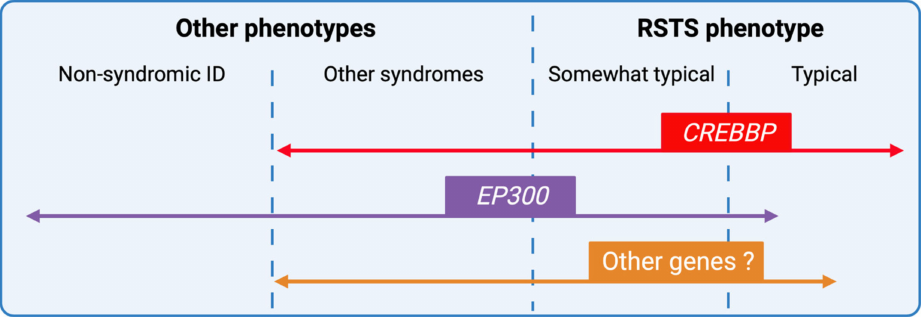
Figure 6. RSTS phenotypic overlap. Next-generation sequencing techniques have increased the number of genomic alterations identified and associated with RSTS phenotype and the phenotypic spectrum leading to complex pheno- type/genotype correlations. CREBBP -mutated individuals present for the majority, a typical clinical diagnosis of RSTS, but the identification of missense mutations in exons 30 and 31 of the gene in patients with non-RSTS phenotype led to the definition of a new clinical entity: the Menke-Hennekam syndrome. EP300 -mutated individuals display a wide clinical spectrum ranging from typical but milder RSTS phenotype to non-syndromic intellectual disability (ID), encompassing the phenotype of other chromatinopathies such as Cornelia de Lange syndrome. More recently, genes involved in others chromatinopathies ( ASXL1 for Bohring-Opitz syndrome, KMT2A for Wiedemann-Steiner syndrome, and KMT2D for Kabuki syndrome) have been identified in individuals with an RSTS phenotype but in the absence of CREBBP/EP300 mutation. The definition of a specific epigenetic signature might reduce diagnostic deadlocks and open new therapeutic